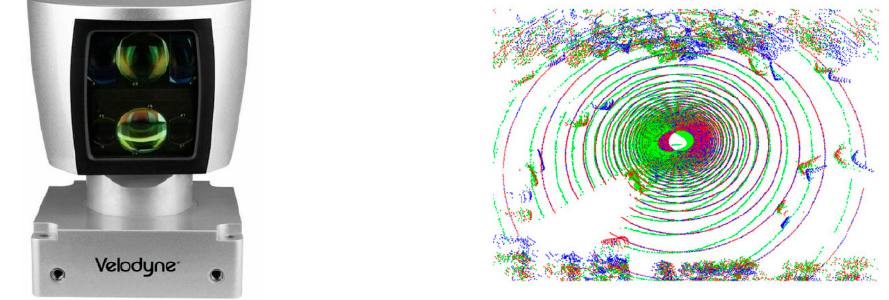
Figure 3. A 3D-LiDAR sensor could be employed for short, medium, telescopic or combinations (dual short range, dual medium) range. Here, a Velodyne HDL-64E sensor and its generated points cloud. (Images source: www.velodynelidar.com; accessed on 29 October 2021).